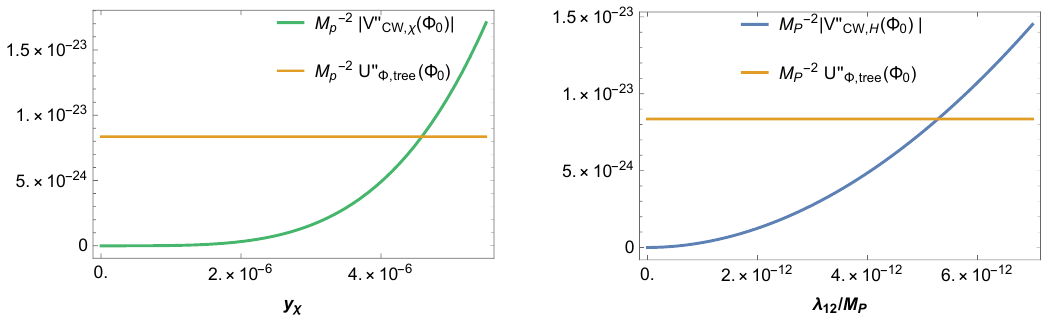
Figure 3. Allowed range for y χ and λ 12 for Model I inflation from stability. The yellow colored line corresponds to tree level potential of Φ . The green and blue colored line represents the CW correction due to χ and H